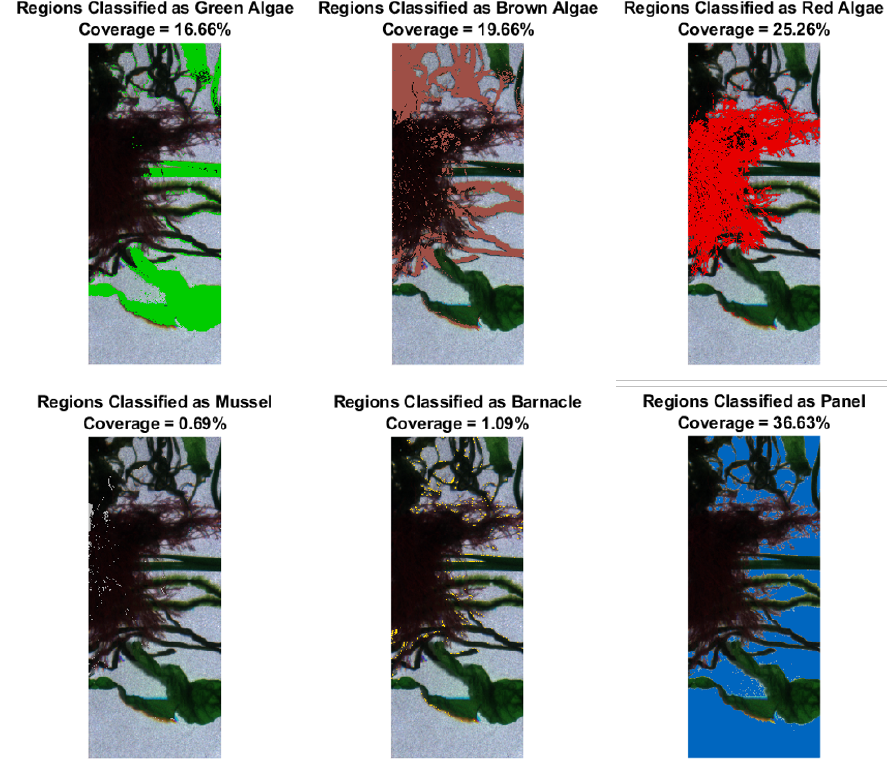
Figure 11. Maps of each category obtained by the WNN classification on the model target, including coverage percentages. The underlying image was obtained by selecting three RGB bands from the hypercube. The overlay indicates the pixels classified as the corresponding